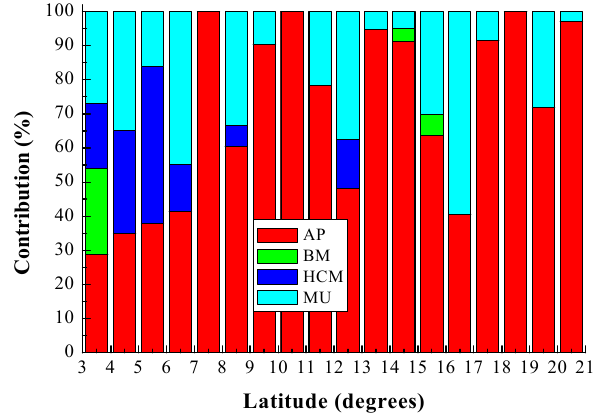
Fig. 7. Contribution (%) of the four aerosol types according to the latitude over BoB during